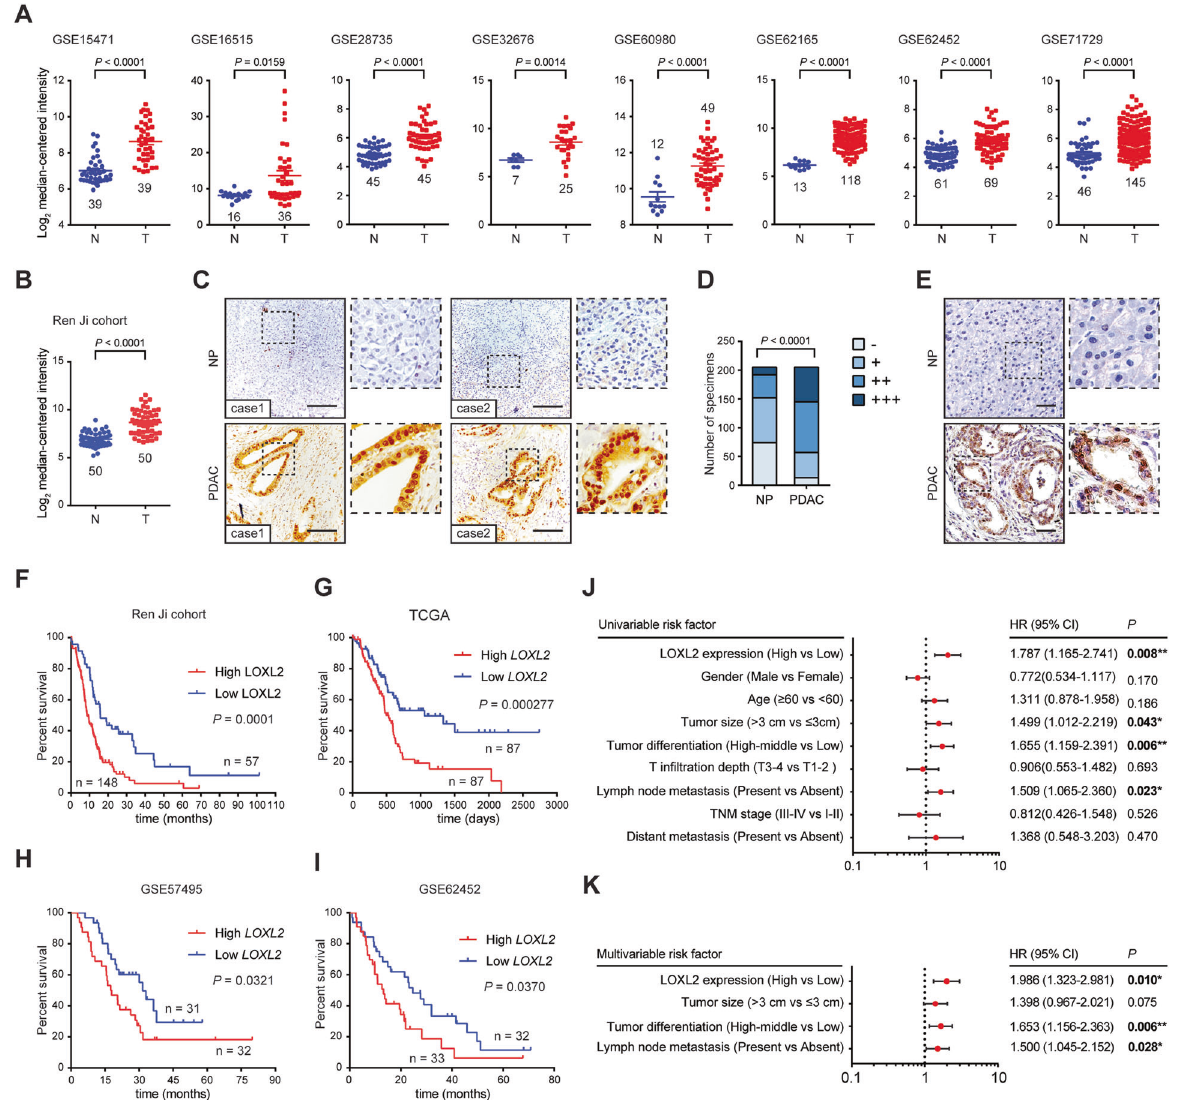
Fig. 1 Expression pattern and prognostic value of LOXL2 in PDAC tissues. A LOXL2 mRNA expression in PDAC tissues (T) and normal pancreas tissues (N) by analyzing multiple gene expression pro fi les from GEO database. B LOXL2 mRNA expression in PDAC tissues (T) and normal pancreas tissues (N) from Ren Ji hospital published in GSE102238. C LOXL2 expression in the adjacent normal pancreas (NP) and PDAC tissues in tissue microarrays revealed by IHC staining and representative IHC images of LOXL2 in NP and PDAC tissues. Scale bar: 50 μ m. D The percentage of tissue cores displaying no ( − ), weak ( + ), moderate ( ++ ), or strong ( +++ ) IHC staining of LOXL2 in NP and PDAC tissues. E Representative IHC images of LOXL2 staining in NP and PDAC tissues from Kras G12D/ + ; Trp53 R172H/ + ; Pdx1-Cre; (KPC) mice. Scale bar: 50 μ m. F Comparison of overall survival of PDAC patients with different LOXL2 expression in Ren Ji cohort, G TCGA cohort, H GSE57495 cohort, and I GSE62452 cohort. Survival curves were calculated via the Kaplan-Meier method and analyzed by the log-rank test. J Univariate and K Multivariate analyses showing the association between LOXL2 expression and PDAC survival. CI Con fi dence interval, HR Hazard ratio. * p < 0.05, ** p <